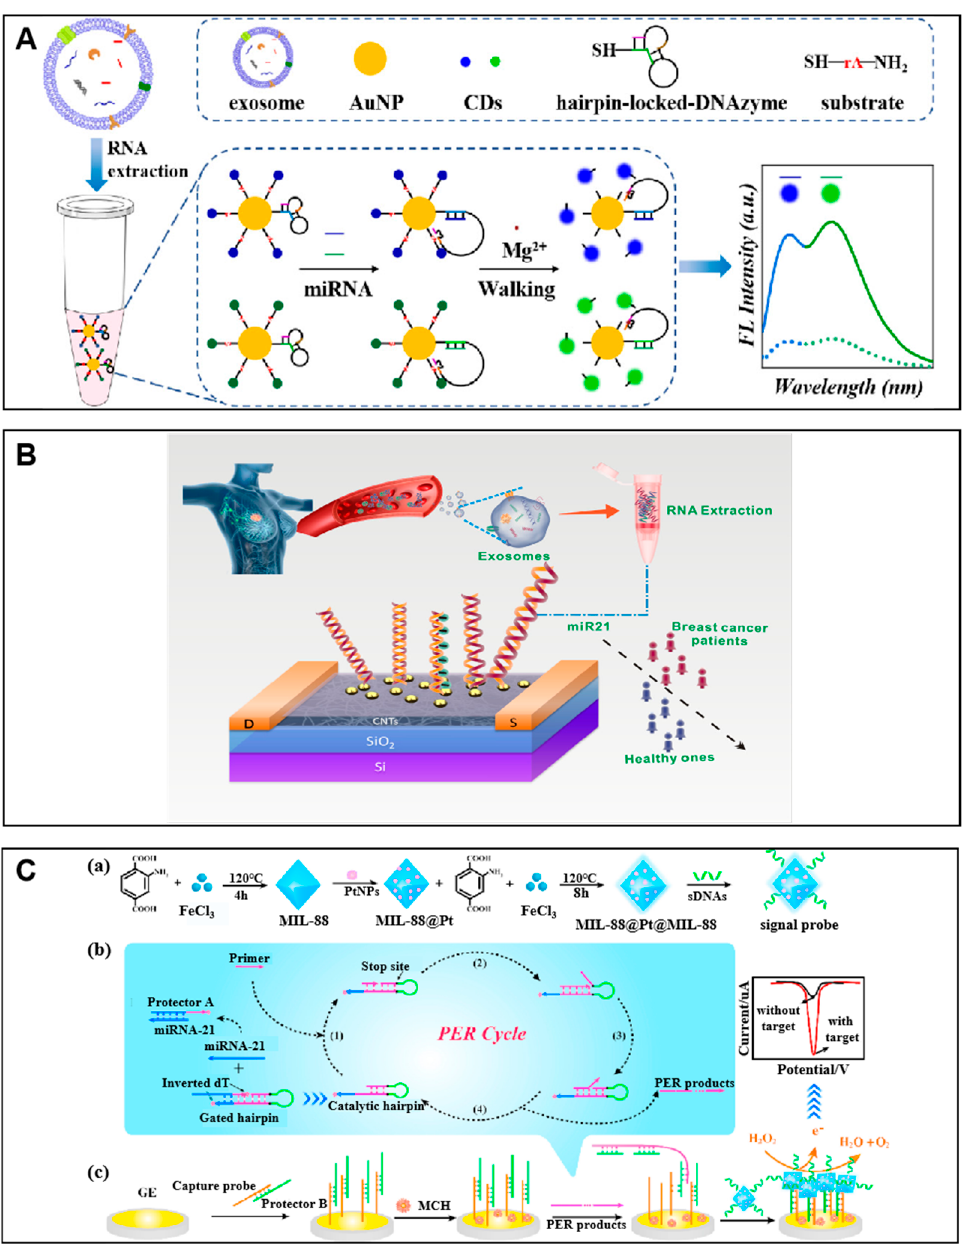
Figure 4. Examples of DNA synergized nanomaterials for exo-miRNA detection. ( A ) Schematic of